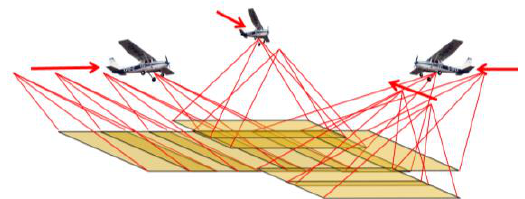
Figure 6. Four sets of master images in the four looking